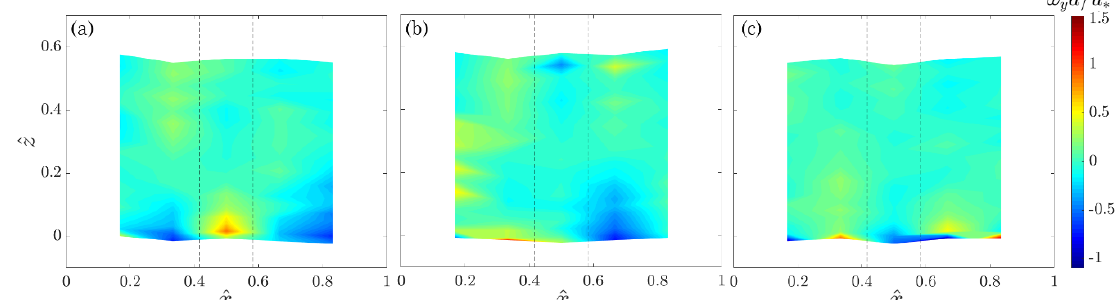
Figure 5. Contours of dimensionless vorticity of the time-averaged flow in the vertical central plane for ( a ) Run 1, ( b ) Run 2, and ( c ) Run 3. The black broken lines indicate the edge of the vegetation stem.